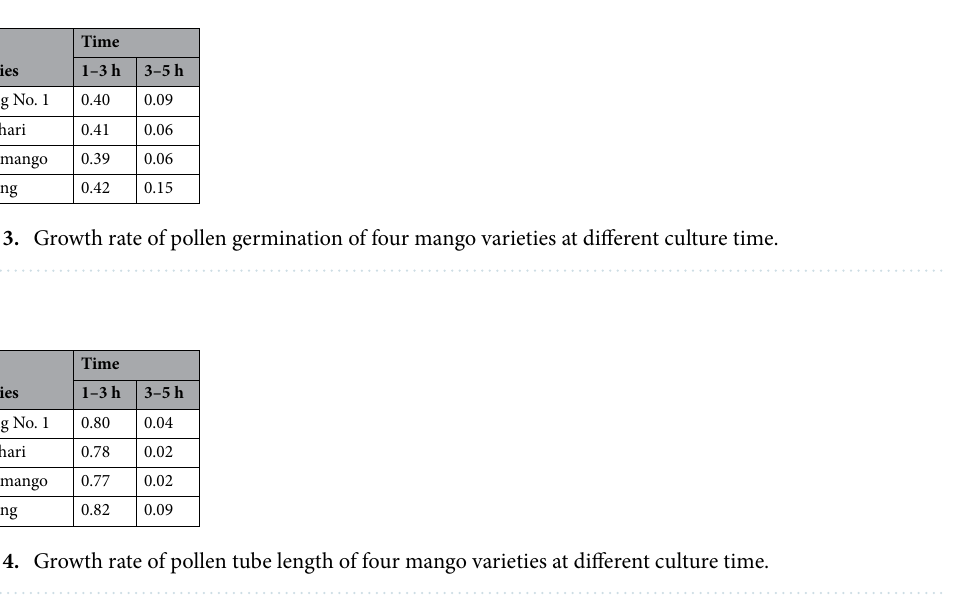
Figure 4. Differences of pollen germination rate ( a ) and pollen tube length ( b ) of four mango genotypes.